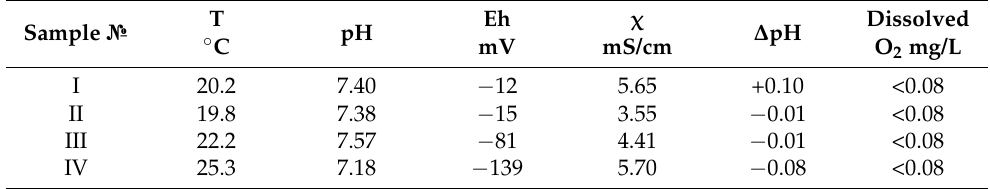
Table 1. Physicochemical parameters of the produced